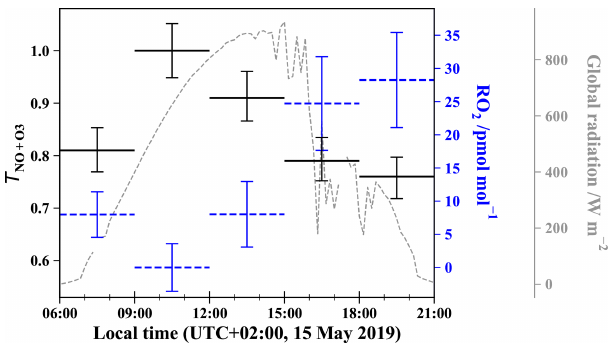
Figure 4. Daytime evolution of T NO + O (solid black lines), esti- 3 mated from Eq. (4) using measured ∆ 17 O(NO 2 ) in Grenoble, and of RO 2 mixing ratios (dashed blue lines), estimated from Eq. (6). Error bars for T NO + O are derived from standard deviations of 3 ∆ 17 O(NO 2 ) and ∆ 17 O(O ∗ ) measured in Grenoble (Vicars and 3 Savarino, 2014). RO 2 error bars are derived from O 3 measurement uncertainties and errors on T NO + O (by comparison, errors on re- 3 action constants can be neglected). Global solar radiation flux is represented by dashed lines (measured at 200m from the sampling site by the IGE weather station with a Skye SP1110